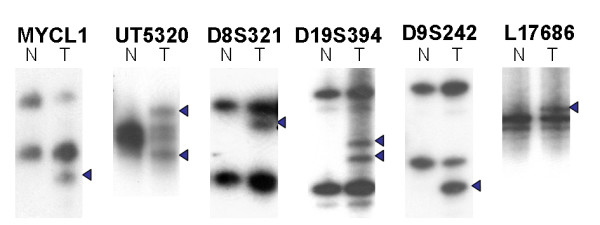
MSI at tetranucleotide repeat markers (EMAST) in type I endometrial carcinioma. Alterations in the electrophoretic mobility of PCR products from tumor compared with normal tissue DNA are seen (arrowheads). (N: normal, T: tumor).